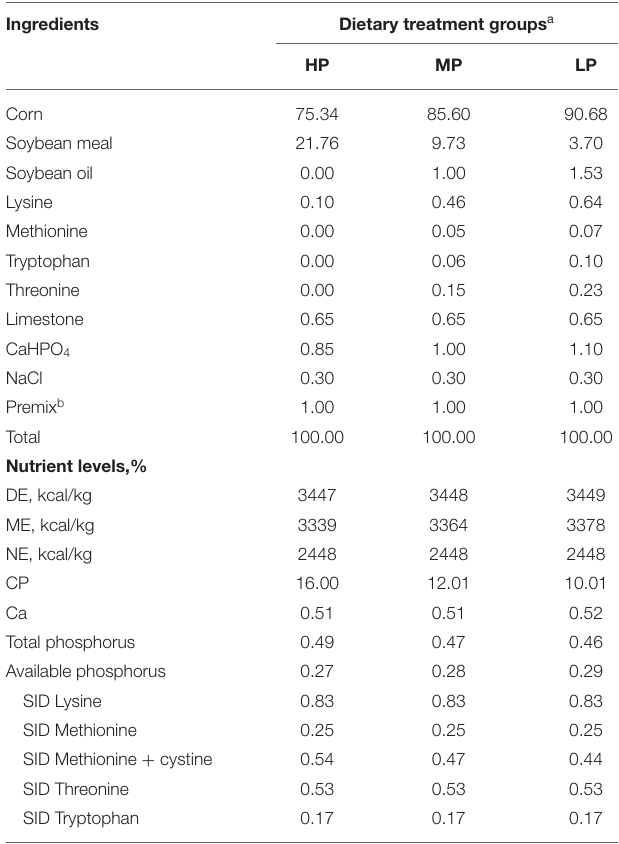
TABLE 1 | Ingredient and nutrient levels of the diets for finishing pigs. Ingredients Dietary treatment groups